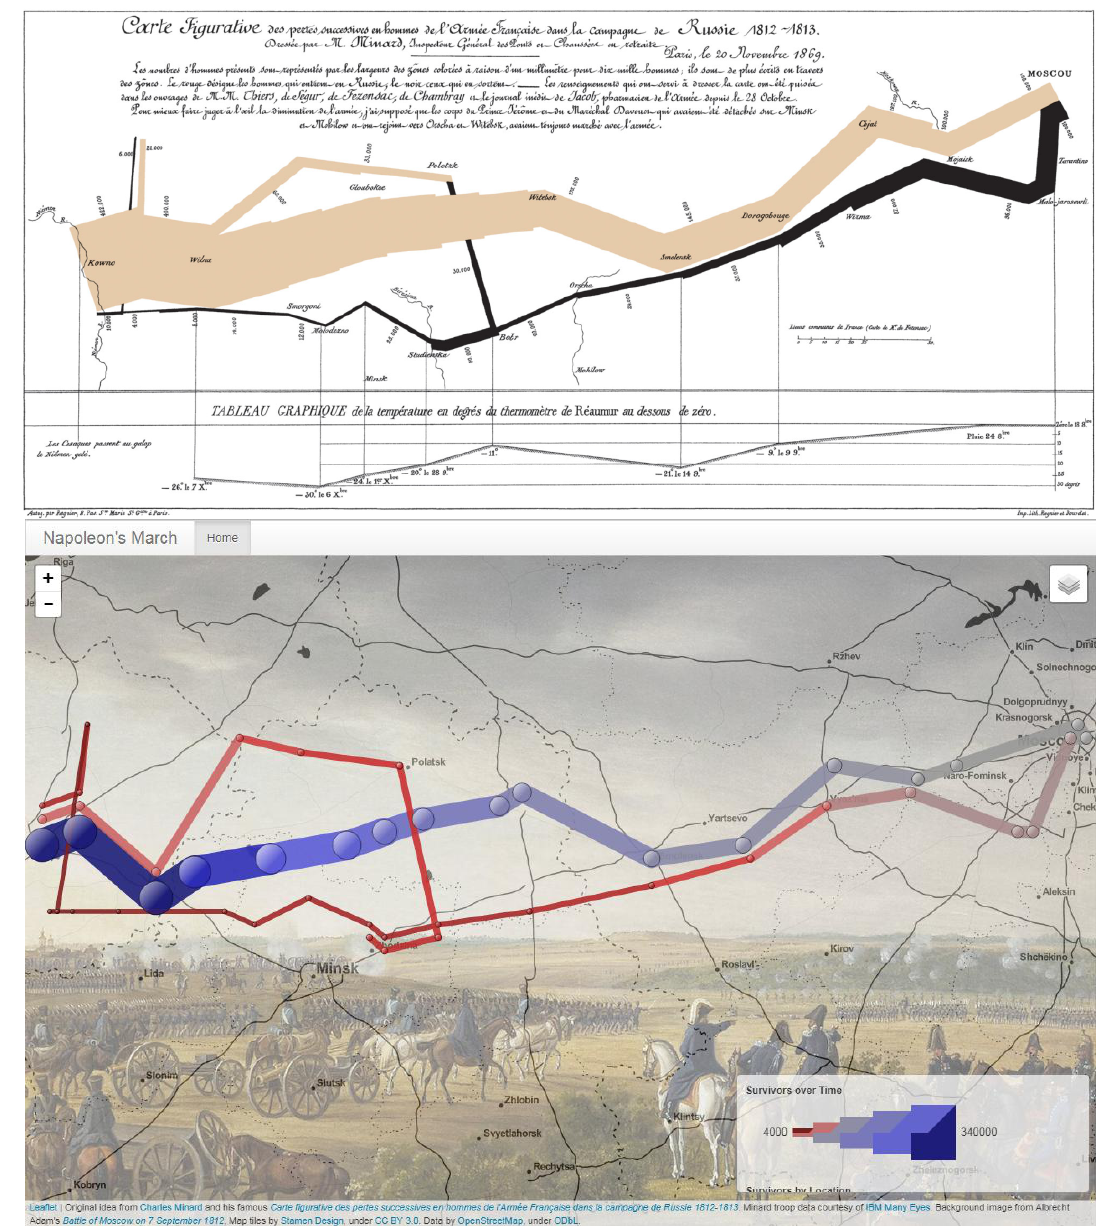
Figure 5. The famous Minard’s 1869 “Napoleon March to and from Russia, 1812–1813”, at the top, and an interactive map based on OpenStreetMap data by Stamen Design (humangeo.github.io/leaflet-